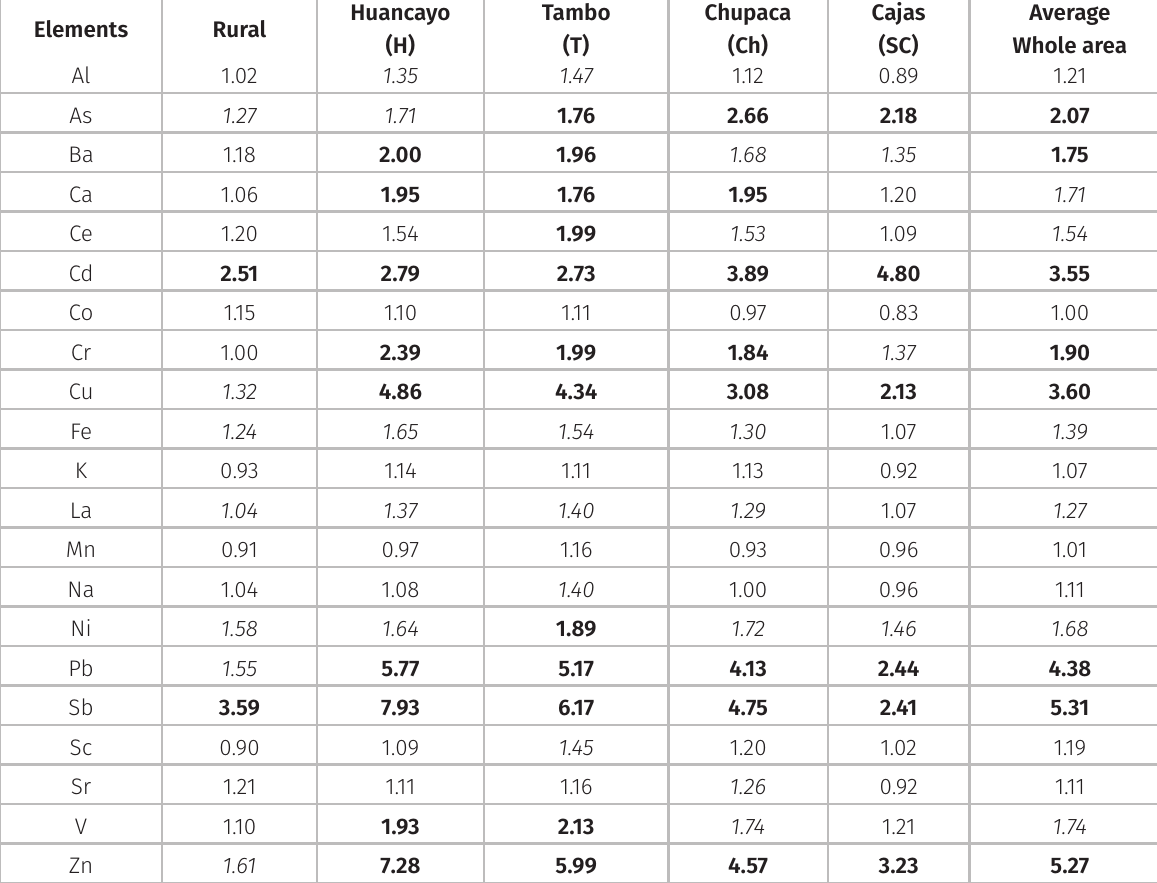
Table IV. EB ratios calculated for 21 elements measured in the samples of transplanted T. capillaris transplanted in each site, after three months of the exposure